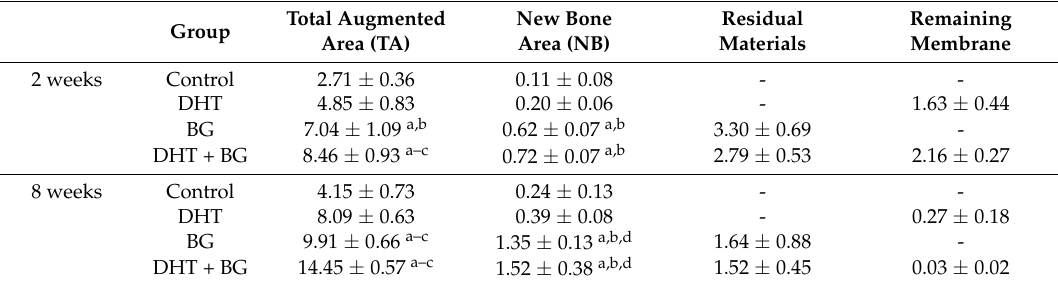
Table 2. Histomorphometric measurements at 2 and 8 weeks after surgery.